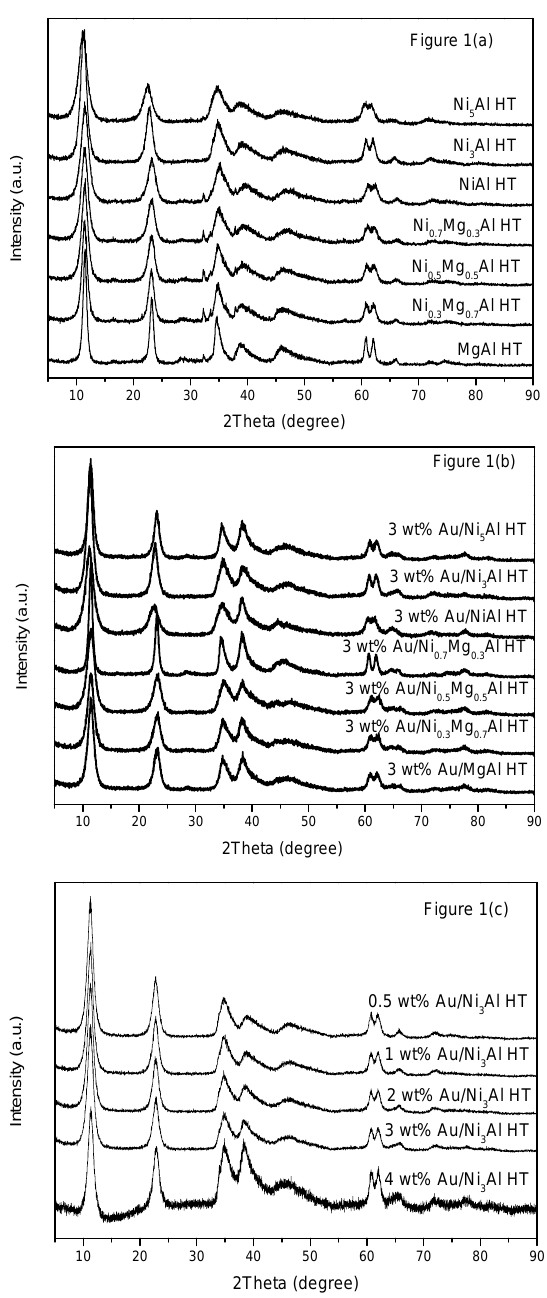
Figure 1. ( a ) XRD patterns of the different supports; ( b ) XRD patterns of the Au catalysts with various supports; ( c ) XRD patterns of the Au/Ni 3 Al HT catalysts with different gold loadings.